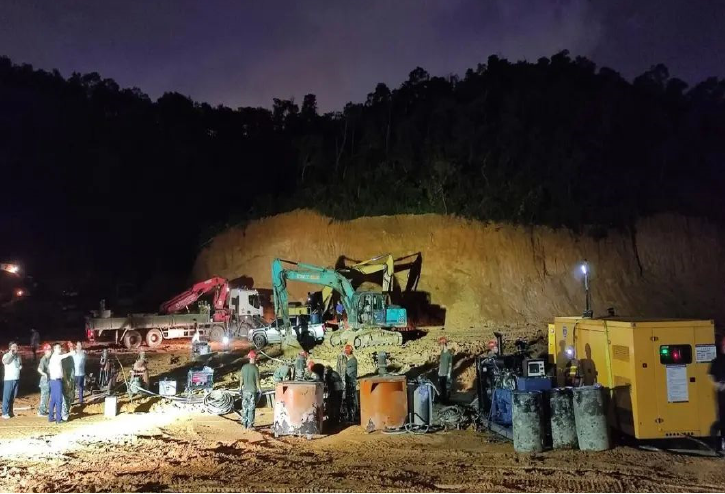
Figure 6. Emergency rescue and surveillance system on the right. (from: https://www.guan- cha.cn/politics/2021_07_17_598831_s.shtml, accessed on 18 January